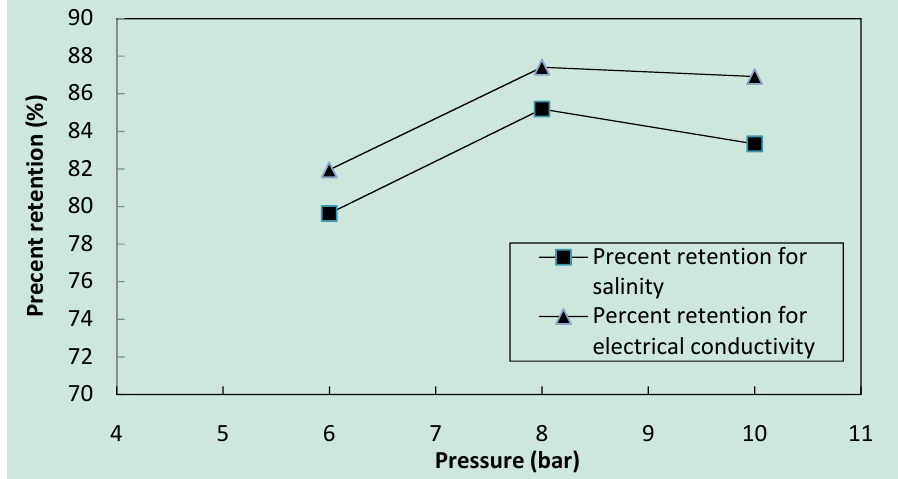
Figure 7. Retention of salinity and electrical conductivity vs . pressure for Sample 2.